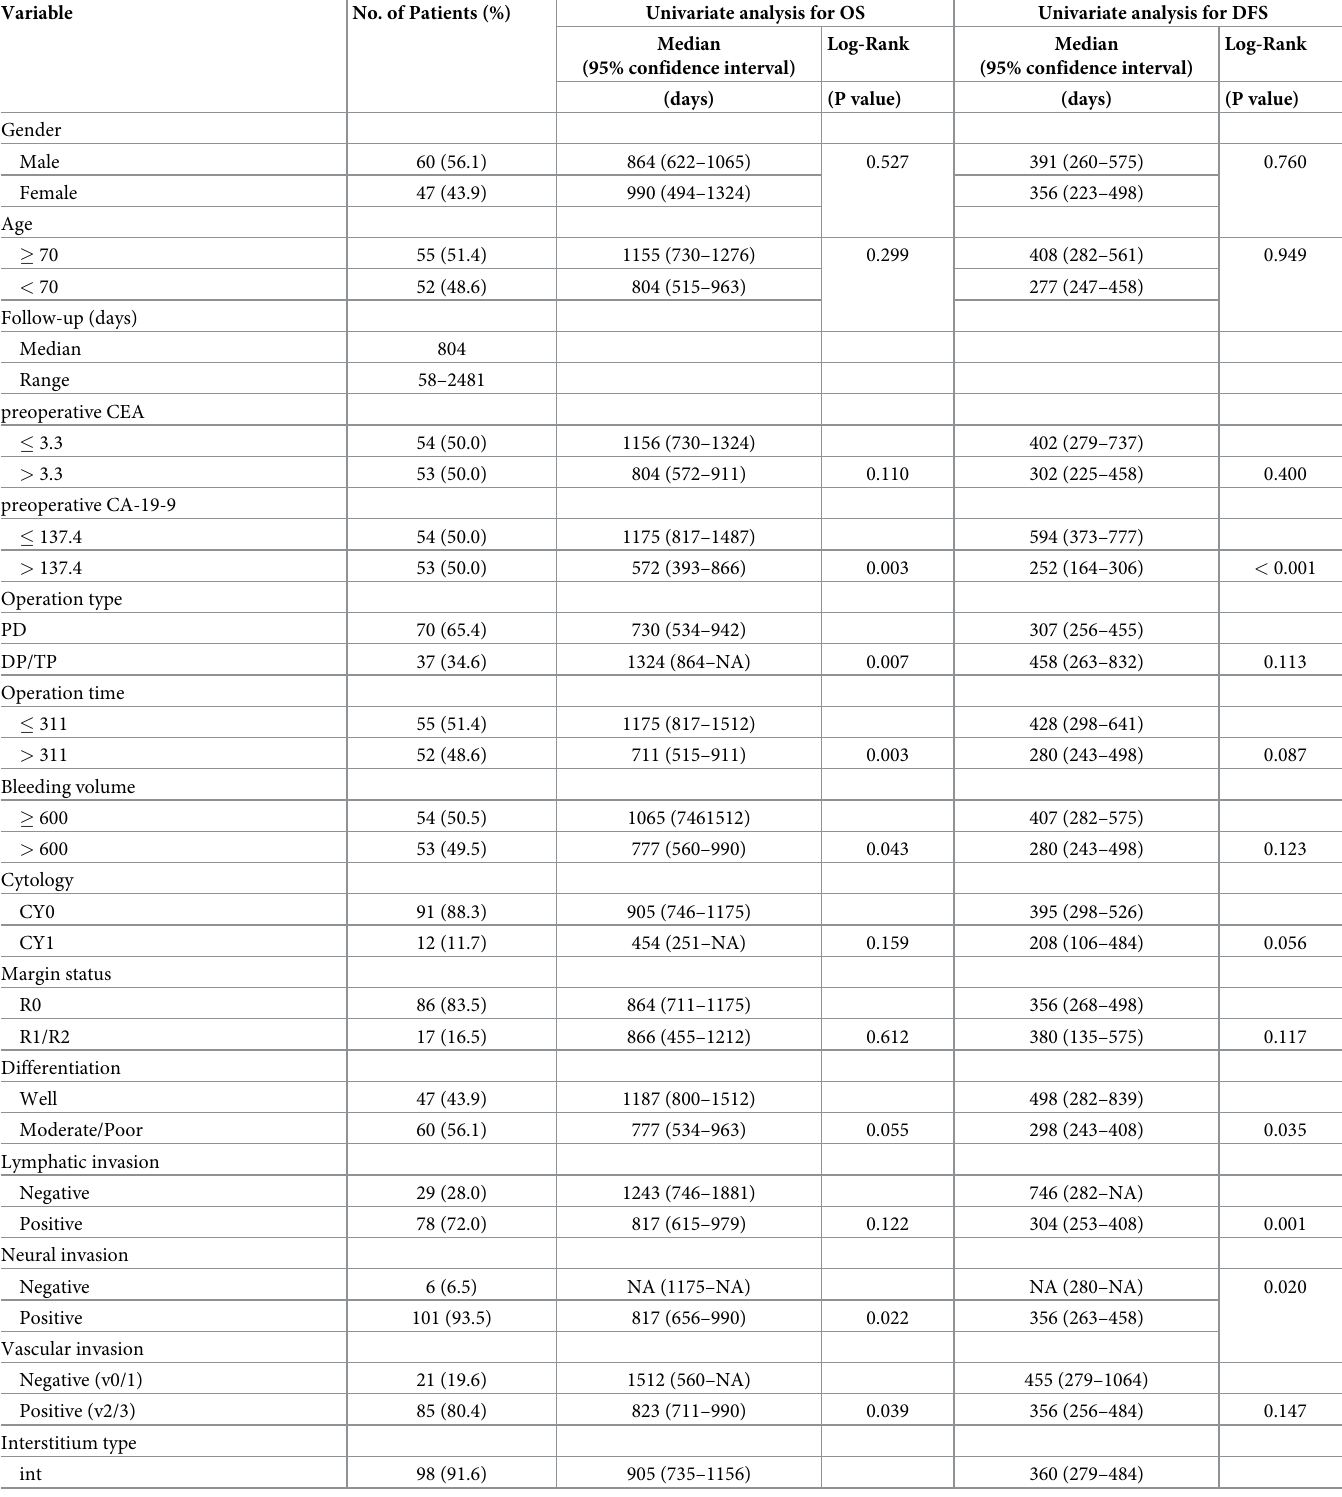
Table 2. Univariate analysis of prognostic factors with ITGB1 for OS and